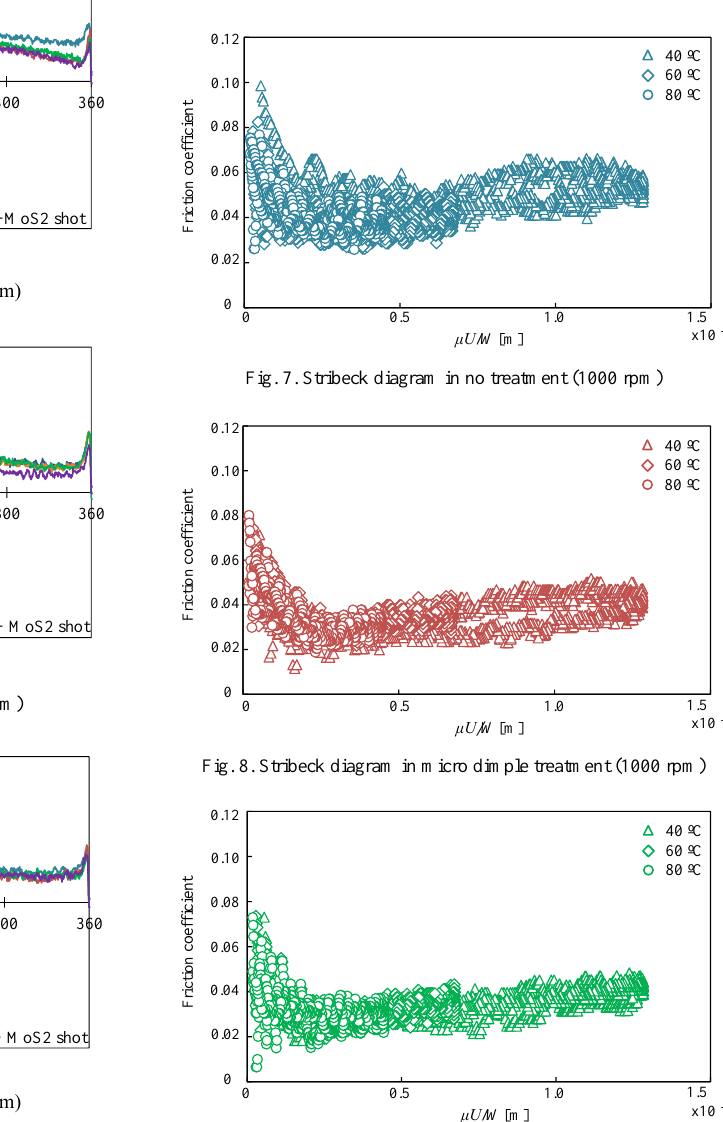
Fig. 6. Piston assembly friction at 80°C (1000 rpm)